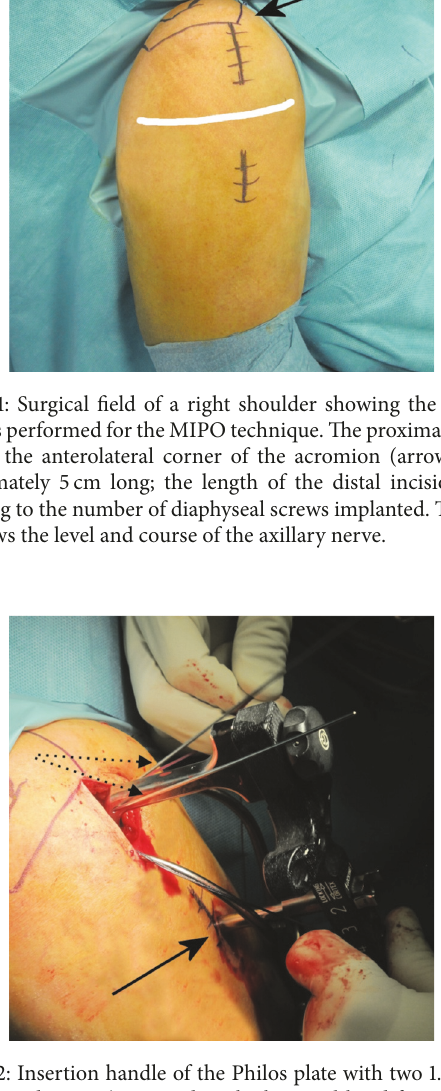
Figure 2: Insertion handle of the Philos plate with two 1.6mm K- wires (dotted arrows) inserted in the humeral head for temporary fixation of the proximal fragment(s). Sleeve system (arrow) for insertion of bicortical locking or nonlocking screws in the humeral